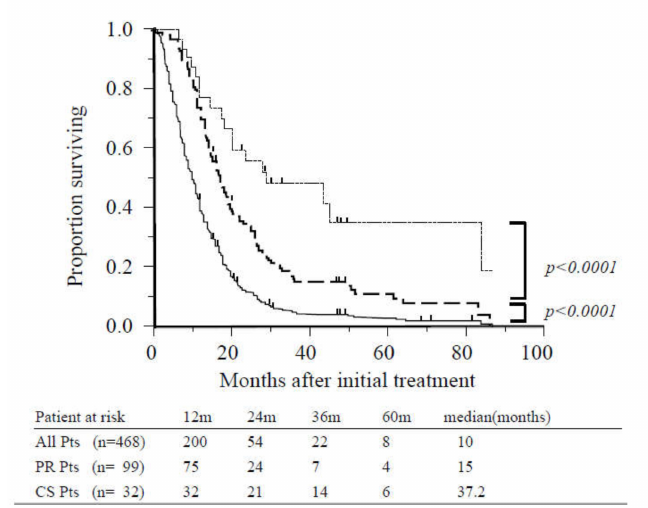
Figure 2. Overall survival of all patients, patients with radiographic partial response, and patients who underwent conversion surgery. The median overall survival (OS) for the study population (solid line, n = 468) was 10 months. Survival was significantly better among patients with partial response (dashed line, n = 99) compared with other cases ( p < 0.0001). Survival of patients who underwent conversion surgery (dotted line, n = 32) was significantly better than those with partial response ( p < 0.0001). Abbreviations: CS, conversion surgery; Pts, patients; PR, partial response.